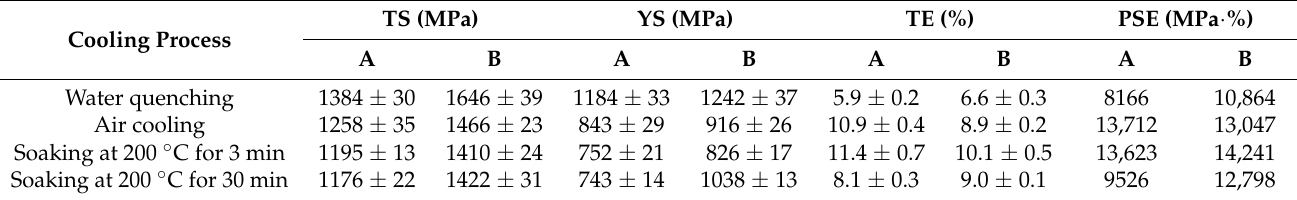
Table 2. Mechanical properties of steels heated at 880 ◦ C for 3 min then treated by different cooling processes. Cooling